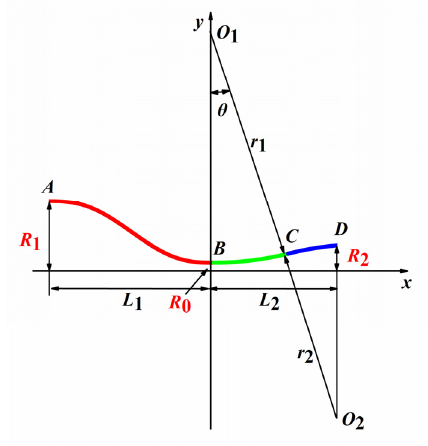
Figure 2. De Laval nozzle curve.